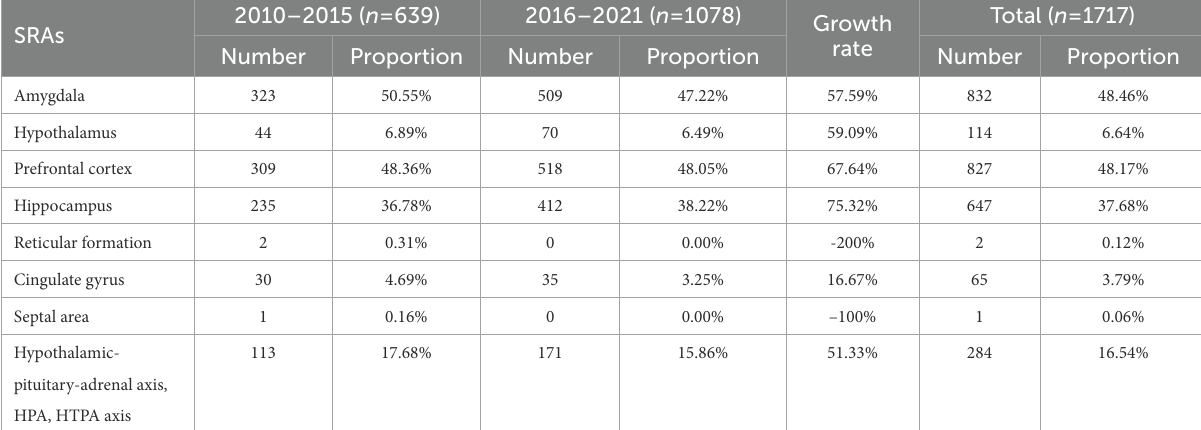
TABLE 6 Literature analysis of different SPAs in 2010-2015 and 2016-2021.